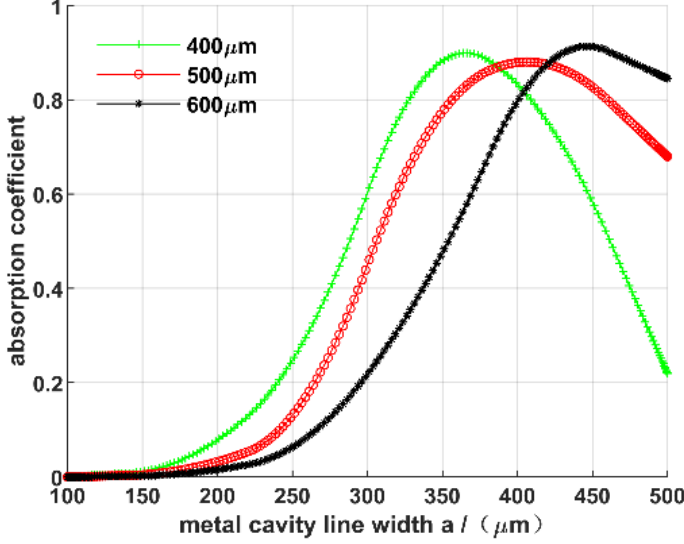
Figure 7. Influence of line width of cavity on absorption.